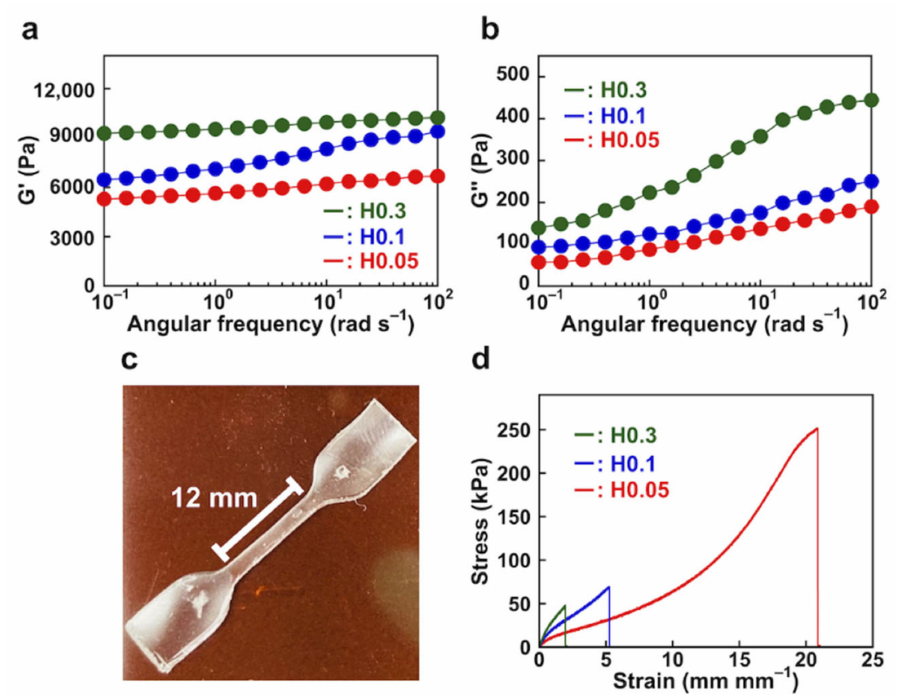
Figure 5. ( a ) Storage modules (G (cid:48) ) and ( b ) loss modules (G”) for PAAm gels recorded at 25 ◦ C. ( c ) Dumbbell-shaped specimen used for stress–strain measurements. ( d ) Stress–strain curves for PAAm gels with a strain rate of 100 mm min − 1 at 25 ◦